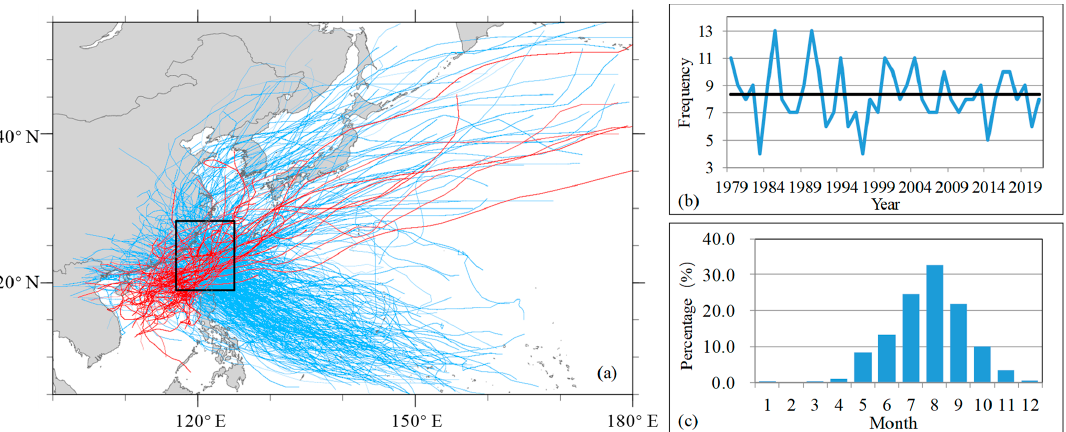
Figure 1. ( a ) Tracks of TCs that enter the study area (denoted by a black rectangle). Red (blue) lines are TCs generated in the South China Sea (the Northwest Pacific Ocean). ( b ) Year-to-year (black line denotes the average frequency) variation of TC occurrence frequency and ( c ) the average percentage of the TC frequency in di ff erent months during 1979–2021 in the study area.